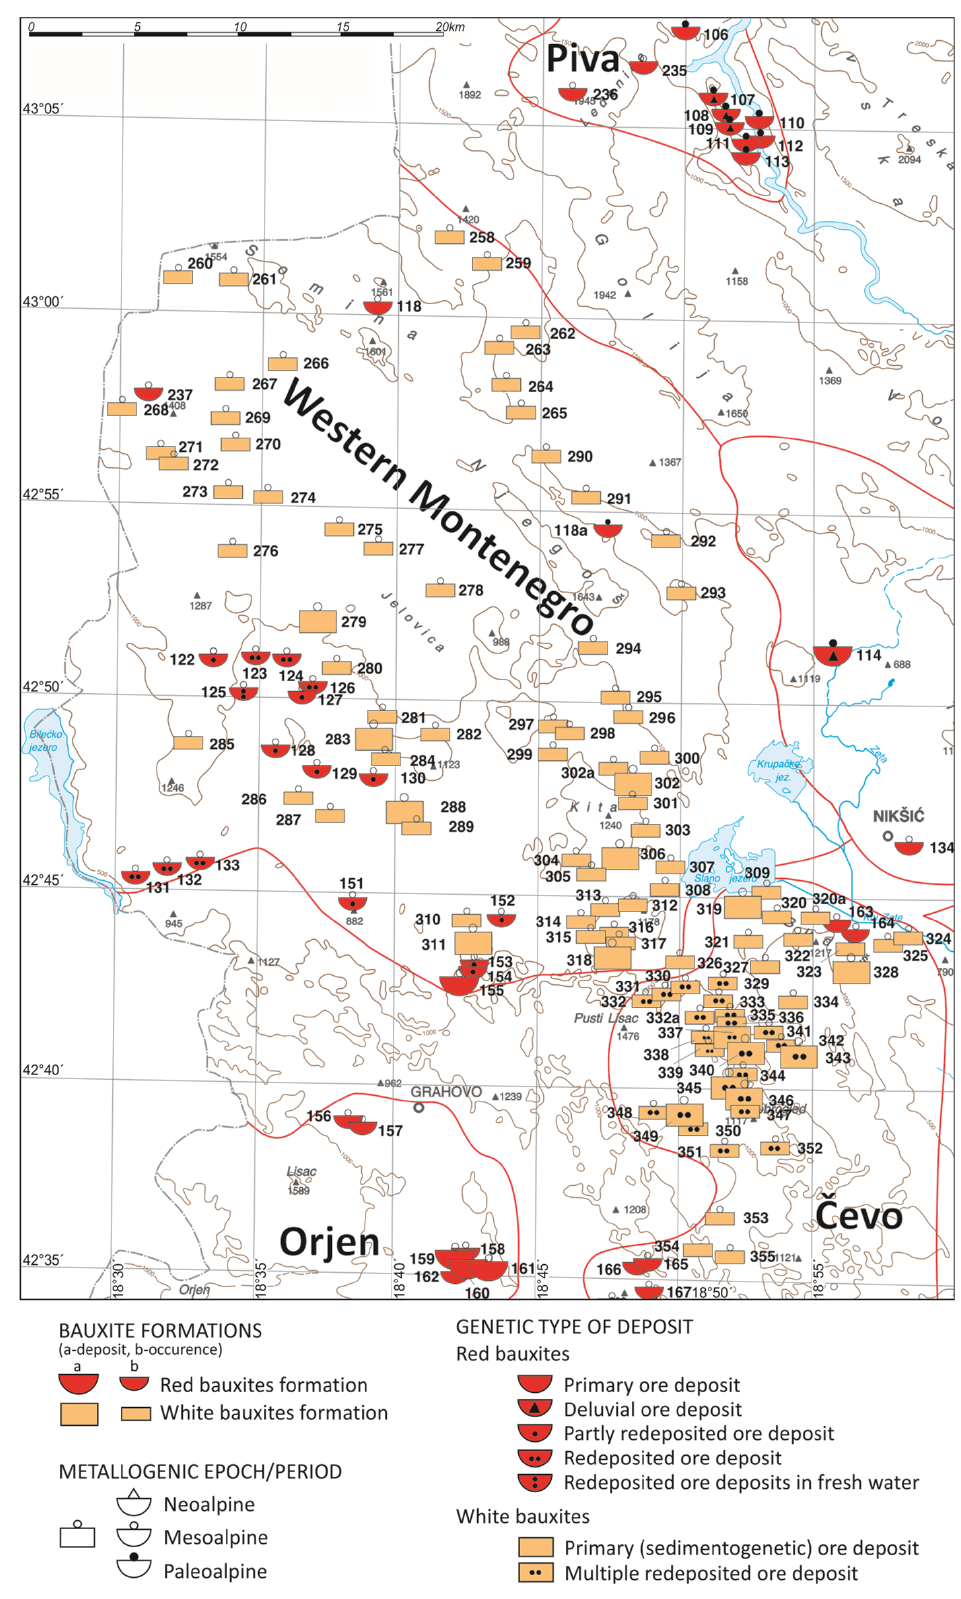
Figure 2. Deposits and occurrences of karstic bauxites of Piva, Western Montenegro and part of Č evo bauxite-bearing regions (after Pajovi ć [15], modified). The legend is the same for Figures 3 and 4. The list of deposits (capital letters) and occurrences of karstic bauxites of Montenegro shown on Figures 2–4, (according to Pajovi ć [15], supplemented): I—Red Bauxites . (a) Triassic ore deposits and occurrences:106 Goransko, 107 Seljani, 108 Rudinice, 109 Crvena stijena, 110 Dubljevi ć i, 111 Rudini č ki brijeg, 112 Bezuja č ke strane, 113 Bukove strane, 114 GORNJOPOLJSKI VIR, 115 Seoca, 116 Žljebovi, 117 Plo č e; (b) Jurassic ore deposits and occurrences:118 Ć urilo, 118a G. Srijede, 119 Provalija, 120 Konate I, 121 Konate II, 122 Crvena šuma, 123 Macavare, 124 Selina, 125 Lastva (Morišta), 126 Crveni do, 127 Milovi ć i, 128 Dugi do, 129 Zaljuta (Pandurica), 130 Štrpca (Tupan), 131 Mrkaji ć i (Kapi ć ), 132 Savina gradina, 133 Grepca (Viluski Bro ć anac), 134 Trebjesa, 135 Raskrsnice,